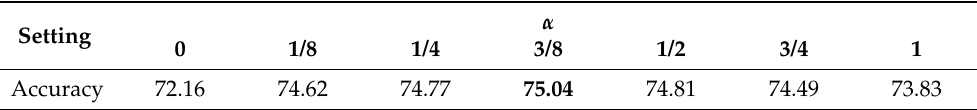
Table 1. Parameter choices of α about Top-1 accuracy. Backbone: R-50. Dataset: the validation set of the Kinetics-400 dataset.